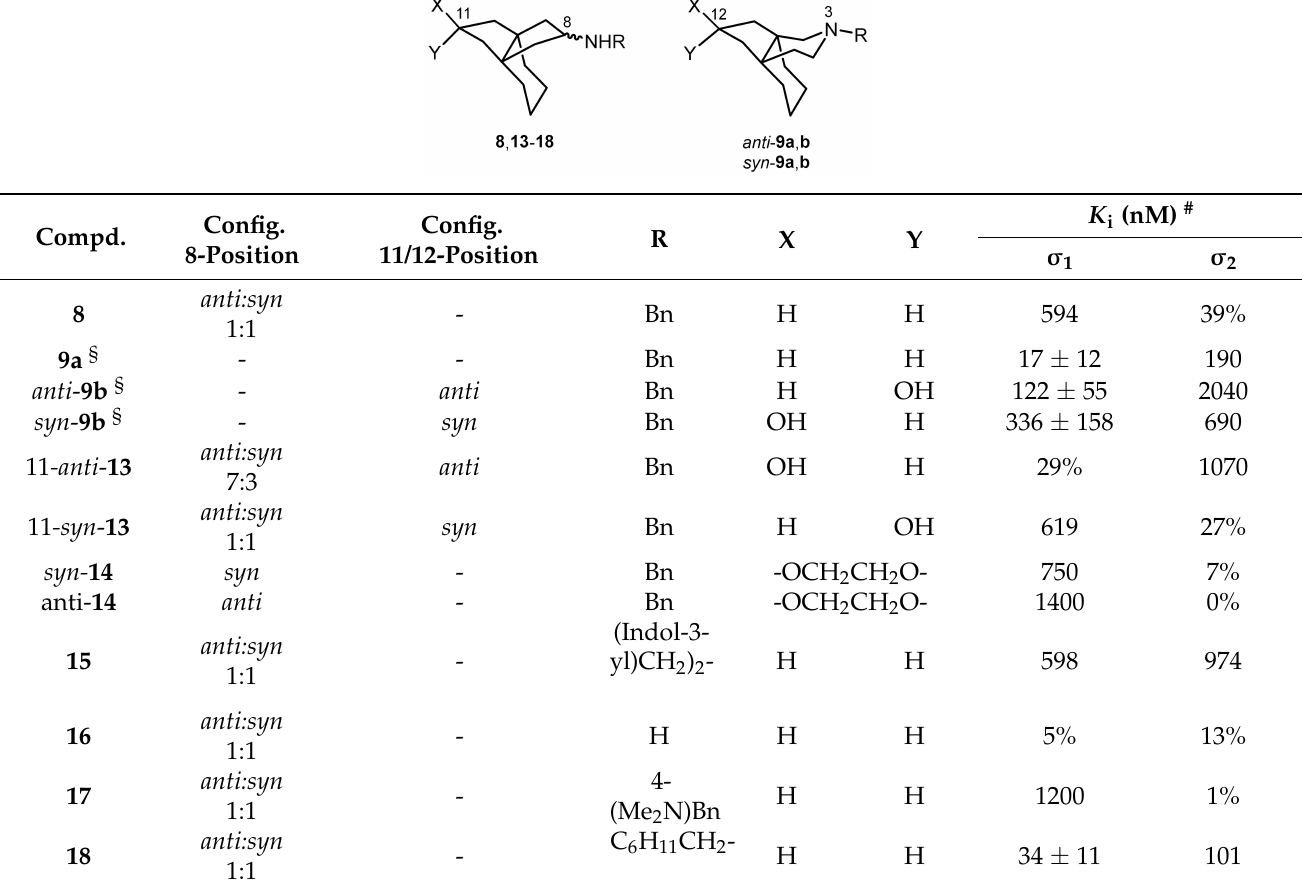
Table 2. Affinities of substituted propellanamines 8 and 13–18 and azapropellanes 9 towards σ 1 and σ 2 receptors.